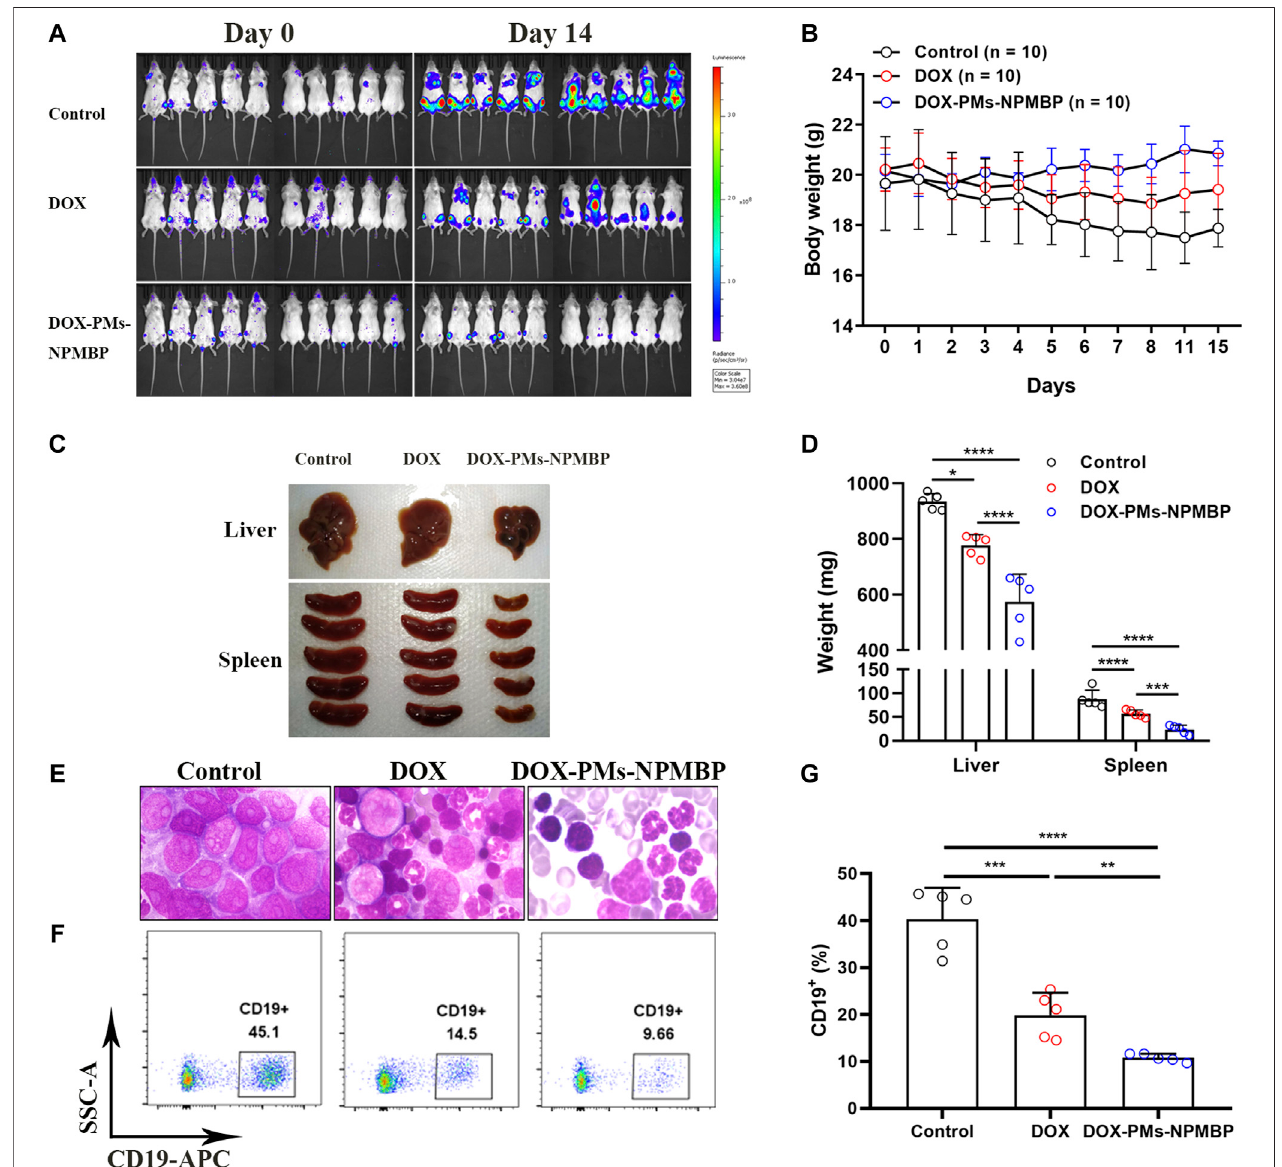
FIGURE 7 | DOX-PMs-NPMBP enhances antileukemia activity in NOD-Prkdc em26 Il2rg em26 Nju (NCG) mice implanted with Nalm6-Luc/DOX cells. A total of 1.0 × 10 4 Nalm6-Luc/DOX cells were infused into NCG mice by tail vein injection. Seven days later, mice were intraperitoneally administered daily single dose of DOX, DOX- PMs-NPMBP, or PBS for 3 days. The day before initial regimen was designated as day 0. Animals were euthanized at the 14th day after the initial treatment. (A) Bioluminescence images of the ventral/dorsal area taken at pre- and post-treatment. (B) Body weights at each time point. (C) Representative photographs of liver and spleen excised from implanted NCG mice. (D) Liver and spleen weight changes in different conditioning group mice. (E) Representative Wright-Giemsa-stained sections of harvested bone marrow (BM) cells in each group mice. (F) Representative images of fl ow-cytogram illustrating the CD19 + Nalm6-Luc/DOX cells in BM. Dot plotsre fl ectCD19-APCvs.sidescatters.* p < 0.05,*** p < 0.001,**** p < 0.0001. (G) ThepercentagesofCD19 + cellsinBMweremeasuredby fl owcytometry.** p < 0.01, *** p < 0.001, **** p <